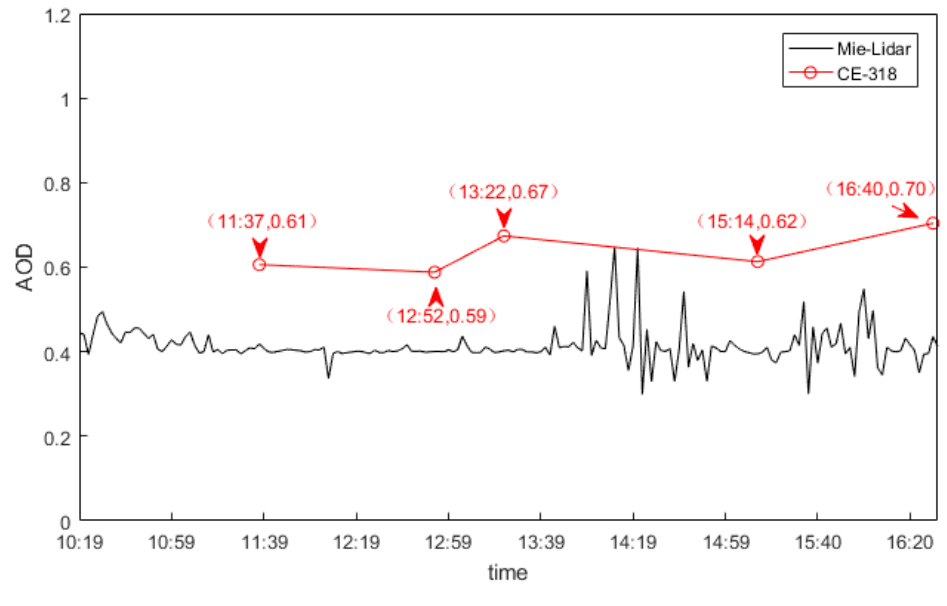
Figure 9. AOD time evolution during June 29.